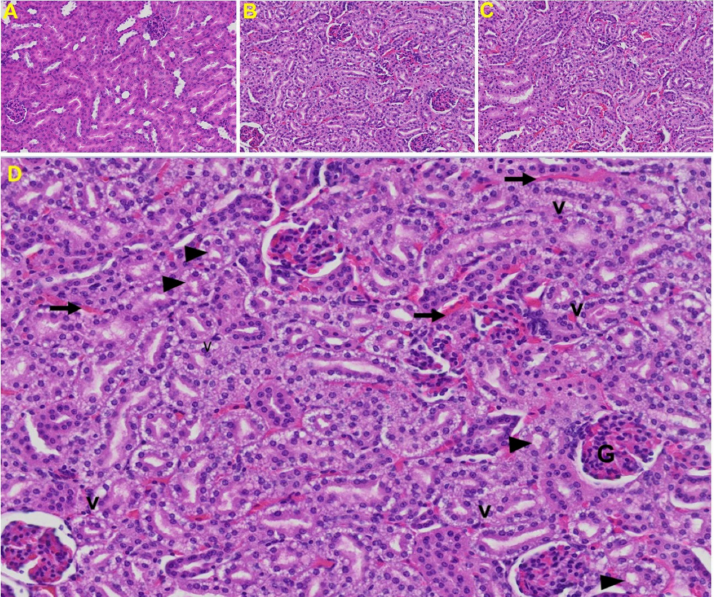
Figure 9. Kidney from an MHV-1 infected mouse. ( A ) Normal mouse kidney. ( B , C ) Kidney sections from an MHV-1 infected mouse. Kidney sections from a control mouse showing a normal histo- logical structure with the glomerulus, proximal convoluted tubule, and distal convoluted tubules. ( D ) Enlarged image of a kidney from an MHV-1 infected mouse showing proximal and distal tubular necrosis (arrowhead), hemorrhage in the interstitial tissue (long arrow), and vacuolation of renal tubules (V) (H&E original magnification of A–C is 400 × as noted in Figure